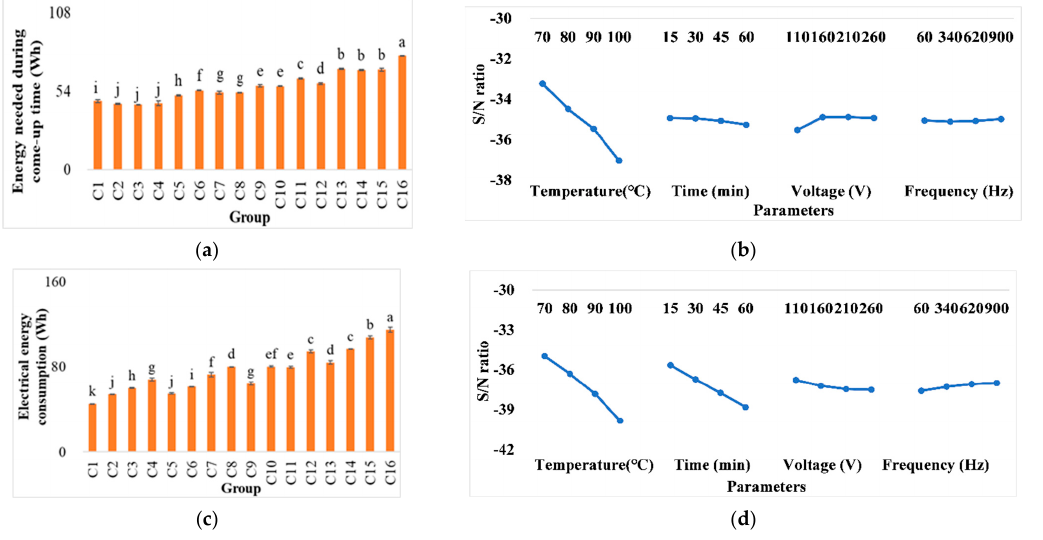
Figure 3. ( a ) The energy needed during come-up time, ( b ) response graph, ( c ) electrical energy consumption, and ( d ) response graph of the lower-better signal-to-noise ratios of the different condi- tions in ohmic heating. Values C1–C16 represent pineapple cores in different treatment conditions including temperature (°C), time (min), voltage (V), and frequency (Hz), respectively: 1: 70, 15, 110, and 60; 2: 70, 30, 160, and 340; 3: 70, 45, 210, and 620; 4: 70, 60, 260, and 900; 5: 80, 15, 160, and 620; 6: 80, 30, 110, and 900; 7: 80, 45, 260, and 60; 8: 80, 60, 210, and 340; 9: 90, 15, 210, and 900; 10: 90, 30, 260, and 620; 11: 90, 45, 110, and 340; 12: 90, 60, 160, and 60; 13: 100, 15, 260, and 340; 14: 100, 30, 210, and 60; 15: 100, 45, 160, and 900; and 16: 100, 60, 110, and 620. The same letters show insignificant differences in the same rows ( p < 0.05). The results are reported as means ± SD. Higher voltages reduced the energy consumption required to heat the sample. Con- versely, lower voltages increased the required electrical energy consumption. The re- duced energy consumption during the come-up time was because of the effects of high voltage on reducing come-up time, reducing the amount of energy loss to the surrounding area. Similarly, an investigation on the ohmic processing of infant food showed that 24 V/cm has a higher heat efficiency than 8 V/cm, reducing the come-up time and energy consumption from 39 to 4 min and 26 to 15 Wh, respectively [30]. Conversely, another study [33] demonstrated that the system performance coefficient was promoted from 0.764 to 0.939 when the electrical field was changed from 55 to 30 V/cm for pomegranate juice processing. A similar trend was reported in another paper on mulberry juice concentration, with a positive coloration between energy consumption and voltage increase. In the studies mentioned above, the evaporation rate was promoted by increasing the voltage gradient, which increased the ion concentration and solution elec- trical conductivity, resulting in different observations from the present study. Overall, it can be considered an advantage of ohmic heating that volumetric heat generation can sig- nificantly boost the heating rate and reduce the processing time [34–36]. 3.3. System Performance Efficiency Figure 4 shows the system performance efficiency at various conditions in ohmic heating. It indicates that the temperature and voltage applied are the significant factors that affect the SPE. It is worth highlighting that at temperatures close to 100 °C, there is a significant adverse effect on system performance. According to the literature [36], the pos- sible cause is the formation of bubbles and the loss of water when the boiling point is reached. The bubbling phenomenon may cause localized changes in the electrical